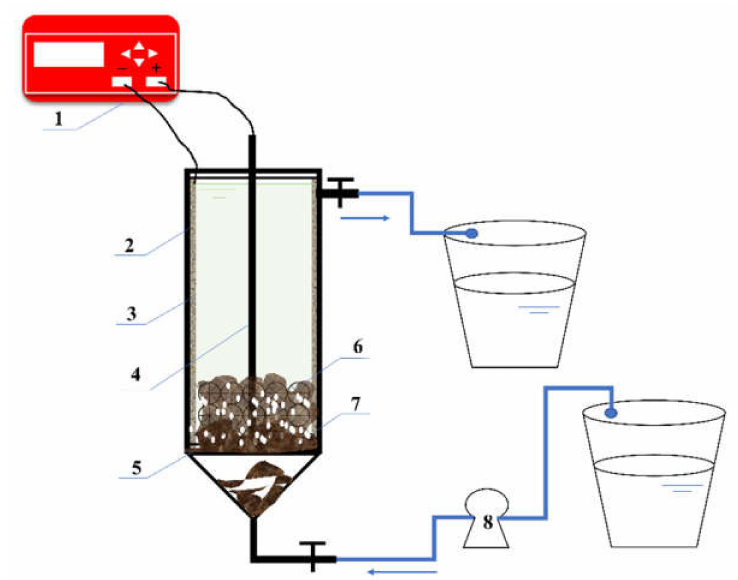
Figure 1. Experimental apparatus. 1 DC Power supply; 2 Reactor; 3 Cathode: Carbon felt; 4 Anode: Graphite rod; 5 Supporting board; 6 PCL; 7 Biofilm; 8 Peristaltic